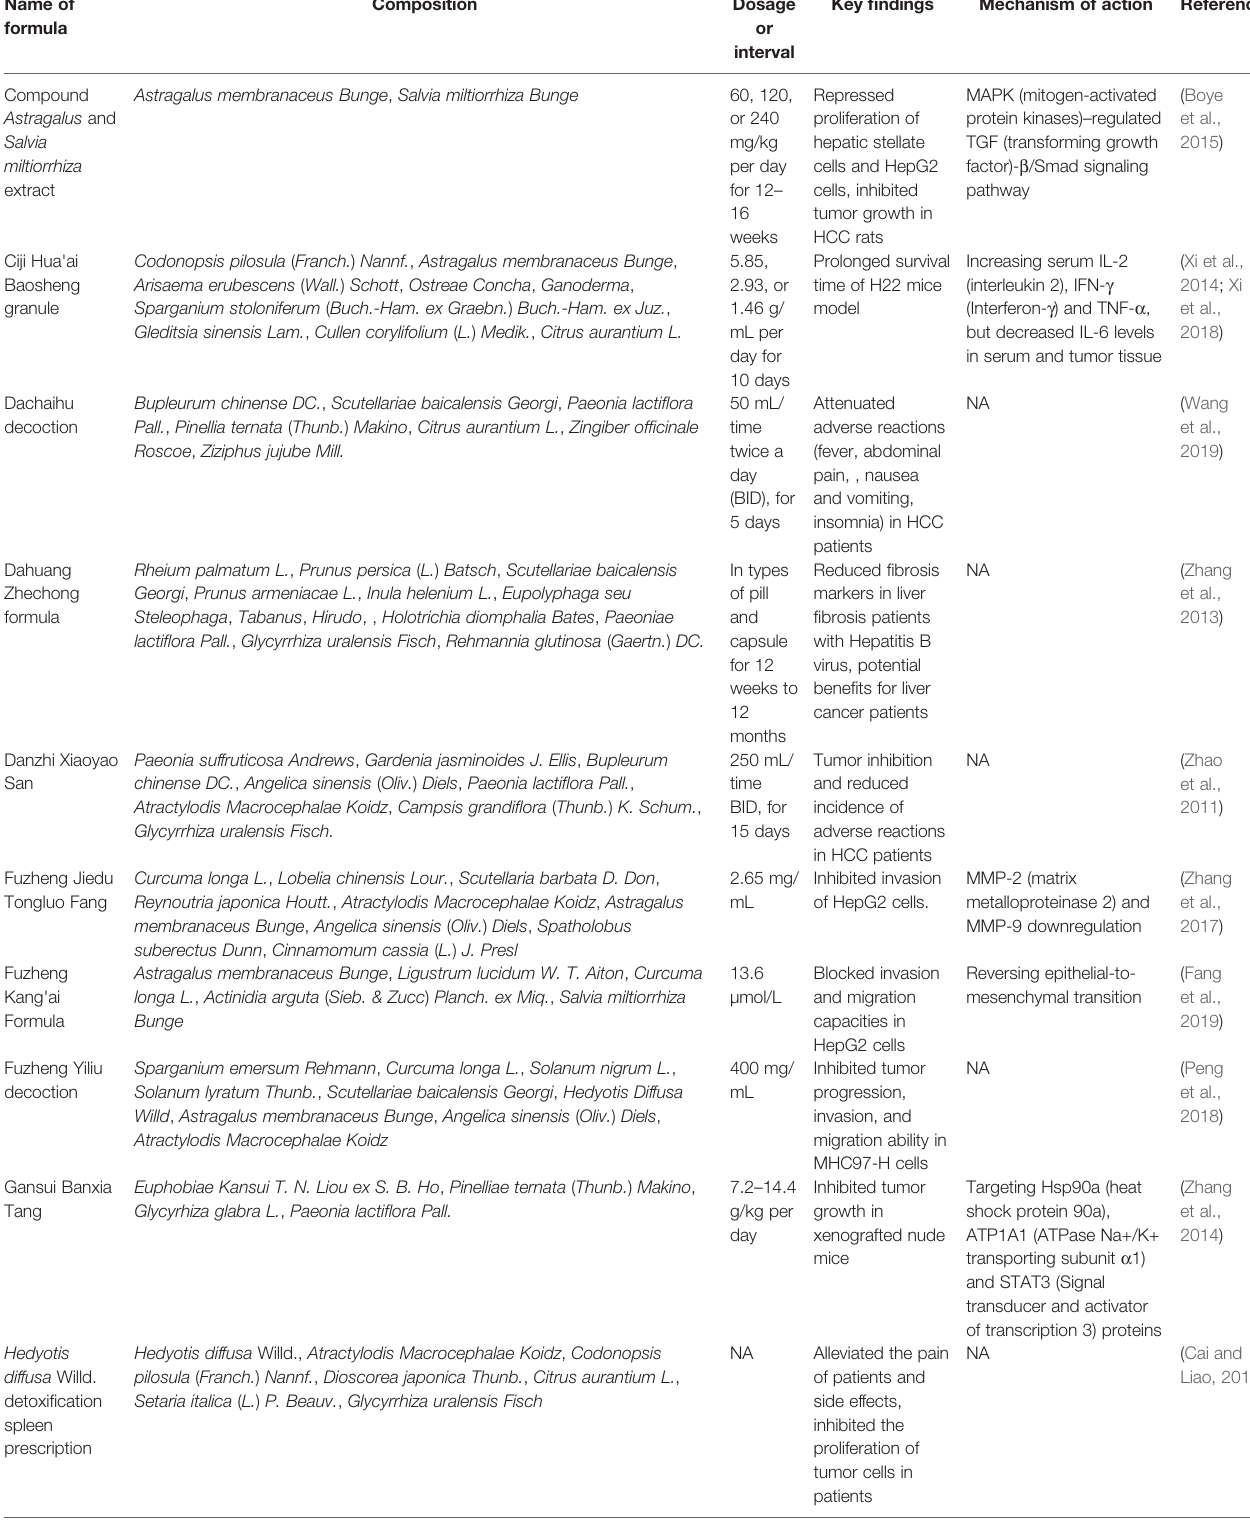
TABLE 1 | Chinese herbal medicine formulas for liver cancer